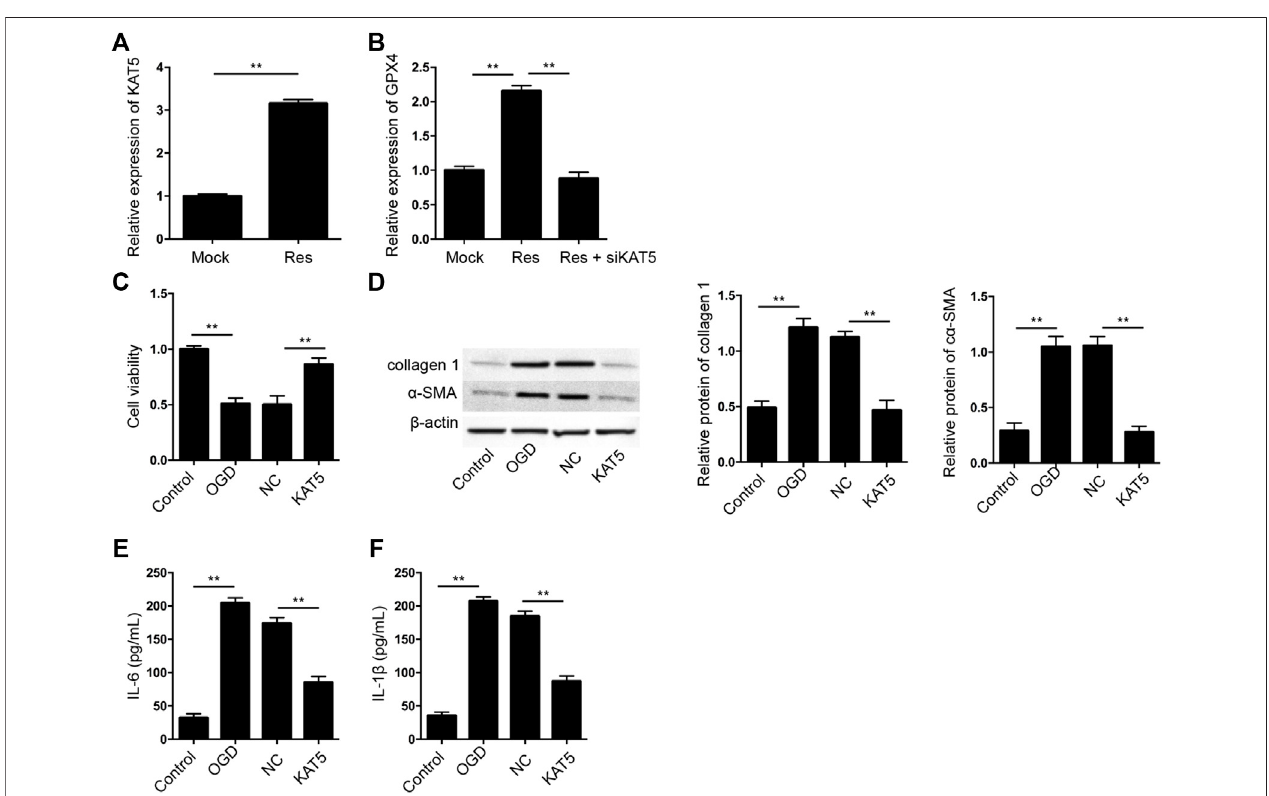
FIGURE 5 | Res enhances GPX4 expression by inducing KAT5 in cardiomyocytes. (A) The expression of KAT5 was measured by qPCR in H9c2 cells treated with Res. (B) Theexpression ofGPX4 was determined by qPCR inH9c2 cellstreatedwithRes and KAT5 siRNA. (C – F) TheOGD-treated H9c2 cells were treated with KAT5 overexpressing plasmid. (C) The cellviability wasmeasured byCCK-8assay. (D) Theexpression ofcollagen1and α -SMAwastested byWestern blot analysisand was normalizedontheexpressionof β -actin. (E,F) ThelevelsofIL-6andIL-1 β weredetectedbyELISA.Control,H9c2withoutOGDtreatment;NC,emptyplasmid.Data are presented as mean ± SD. Statistic signi fi cant differences were indicated: ** p <